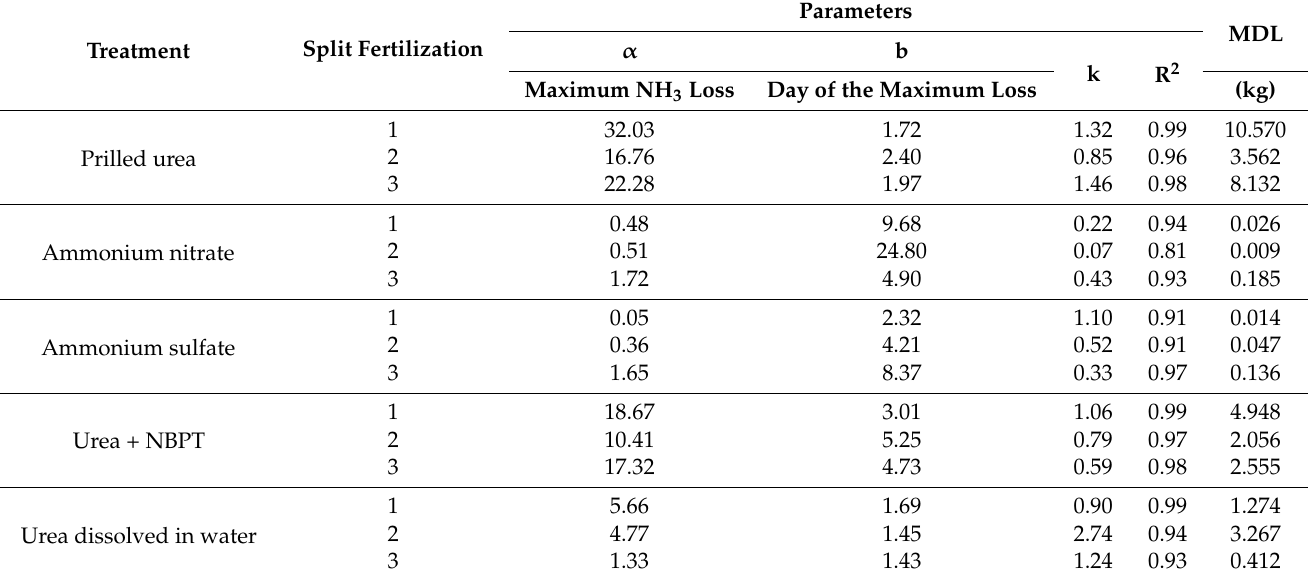
Table 2. Regression parameters adjusted for the accumulated and maximum daily losses of N-NH 3 from conventional and stabilized N fertilizers in the 2016/2017 crop